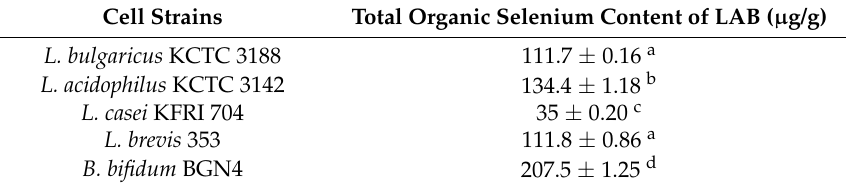
Table 2. Total Organic Selenium in Selenium-Enriched Microorganisms Quantified using inductively coupled plasma-atomic emission spectrometer (ICP-AES). Data is shown as the mean ± SD of the triplicate experiments. Cell Strains